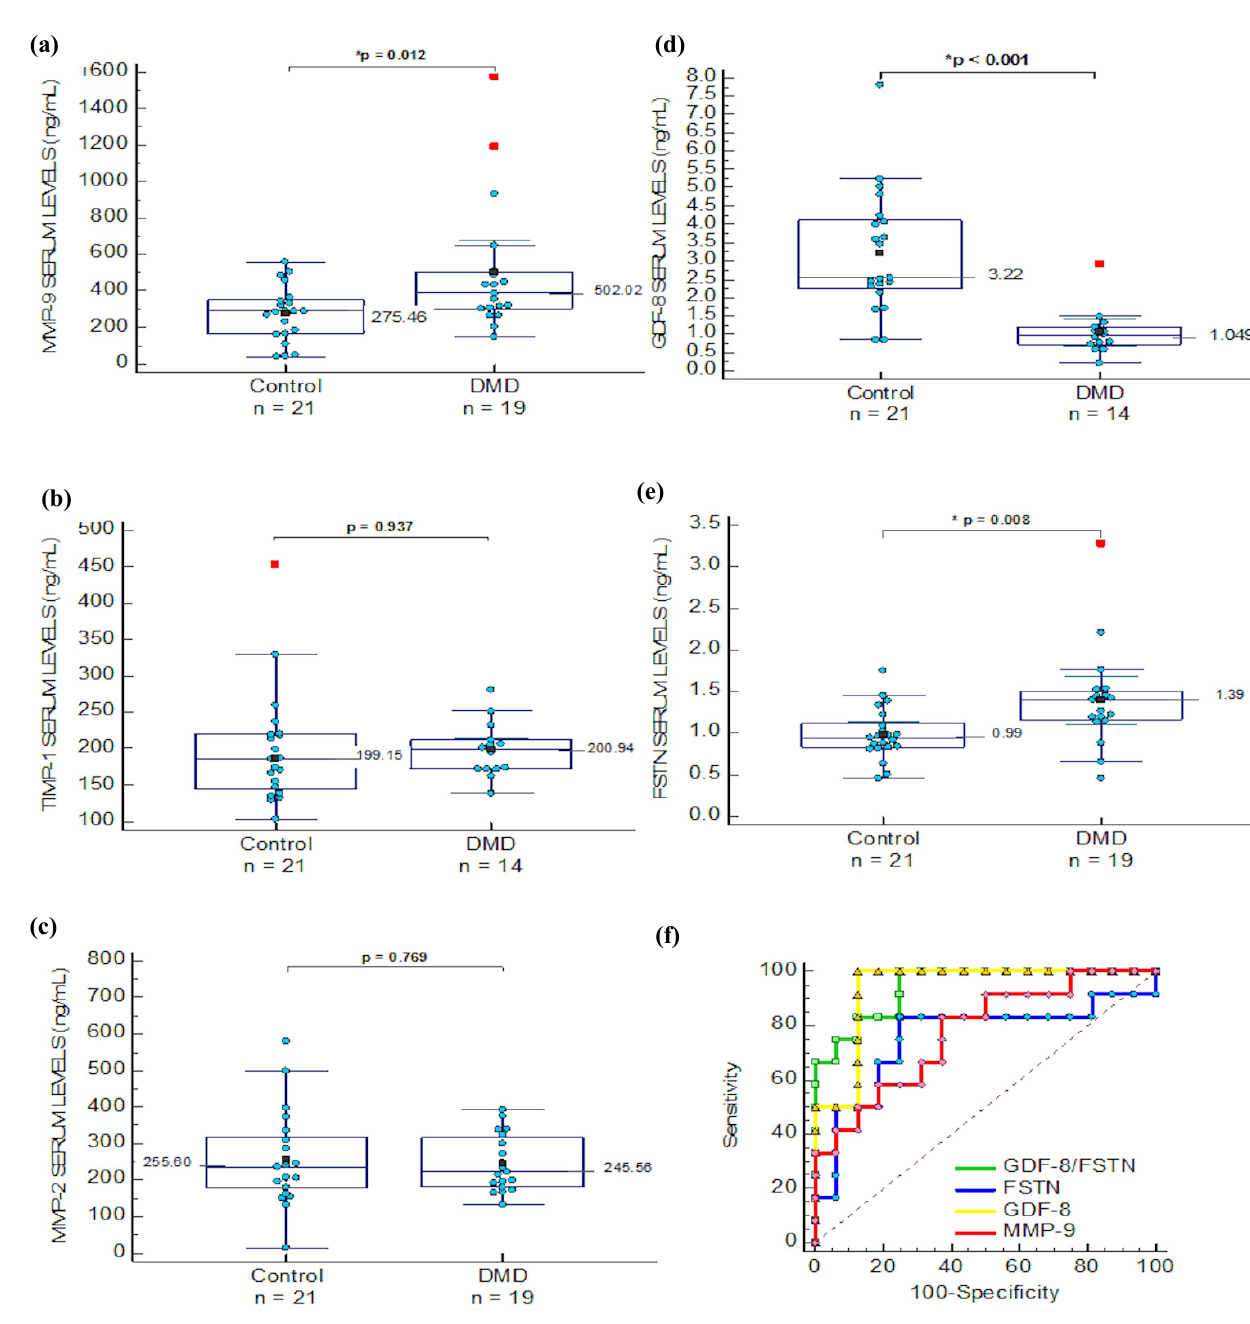
Figure 2. Comparison of serum levels between groups ( a ) MMP-9 levels; ( b ) TIMP-1 levels; ( c ) MMP-2 levels; ( d ) GDF-8 levels; ( e ) FSTN levels; ( f ) Comparison between GDF-8 ( ∆ ), FSTN ( ● ), MMP-9 ( ● ) and GDF-8/FSTN ratio ( □ ) levels ROC